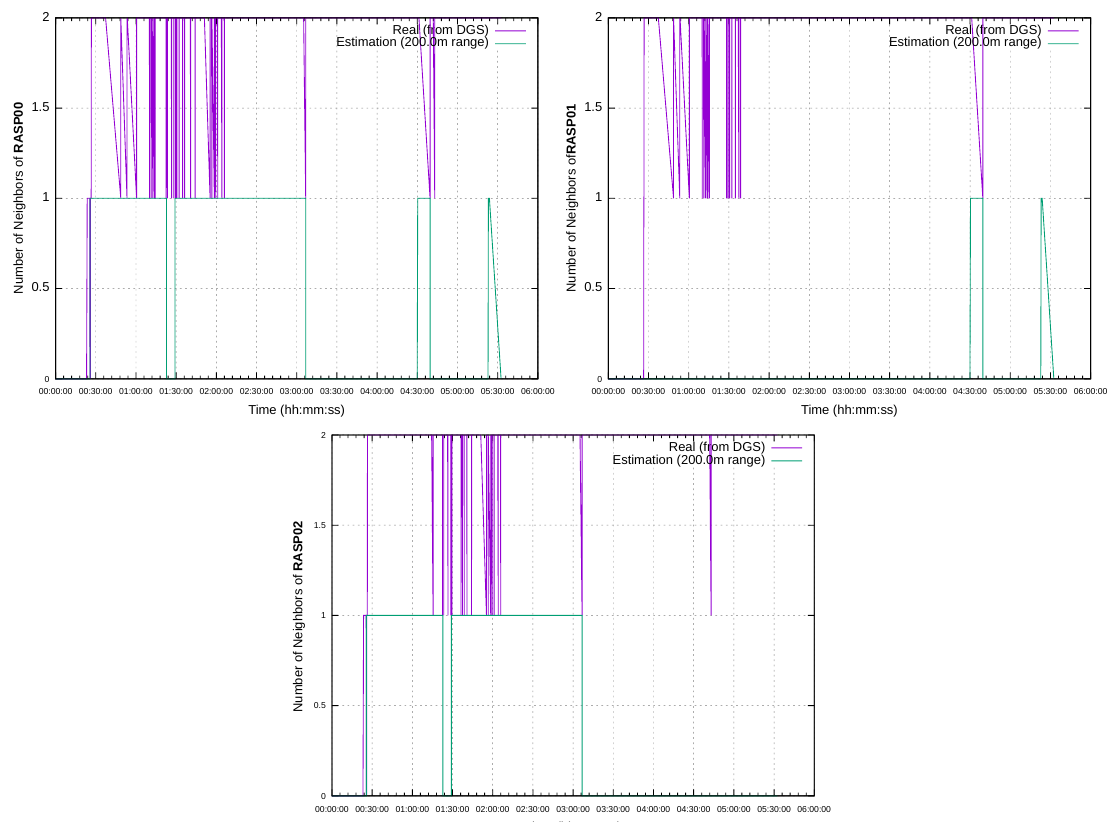
Figure 8. Real contacts vs. estimated contacts of RASP00, RASP01 and RASP02 on Day 1.